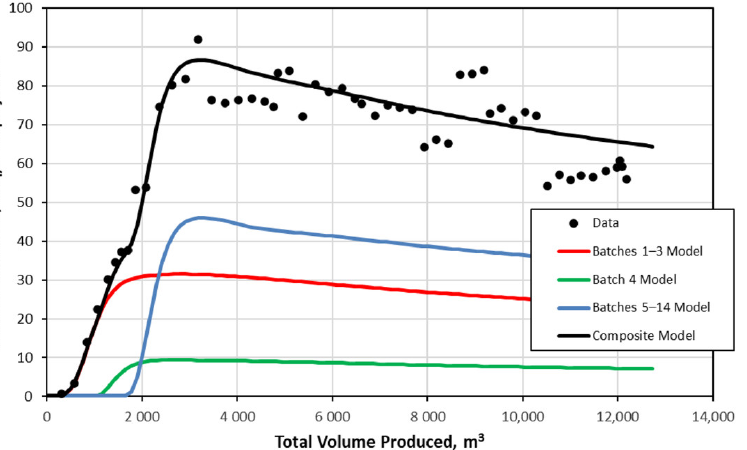
Figure A19. Forward prediction of composite-normalized cation charge breakthrough curve up until the acetate injection in the amendments test using the model parameters associated with the adjusted model curve of Figure A18 and applying a recirculation factor of 0.86. Colored lines show contributions from each of the 3 “separate” injections highlighted in Table A8.